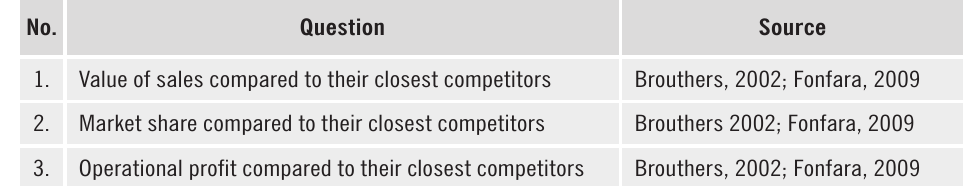
Table 4. Questions concerning the company’s competitiveness from the questionnaire about 2019